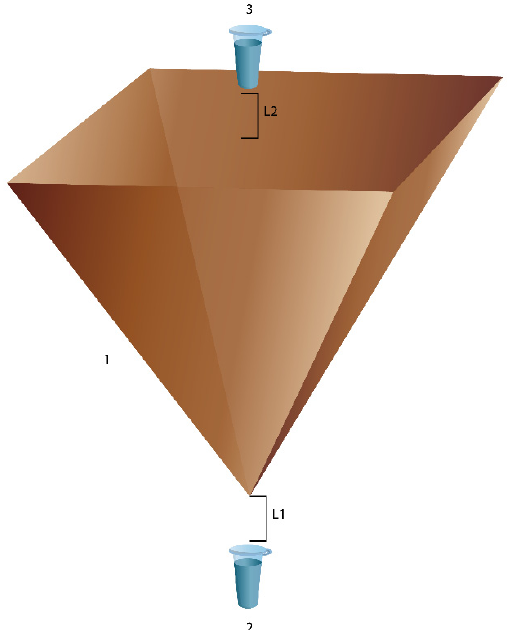
Figure 1. Experimental setup. Numbers indicate the main units of the setup: the ISP (1) and the test tube with the enzyme solution. The tube was placed either below the ISP’s apex (2) or above its base (3). L 1 and L 2 represent the distance between the tube and the ISP’s apex or the center of its base, respectively.